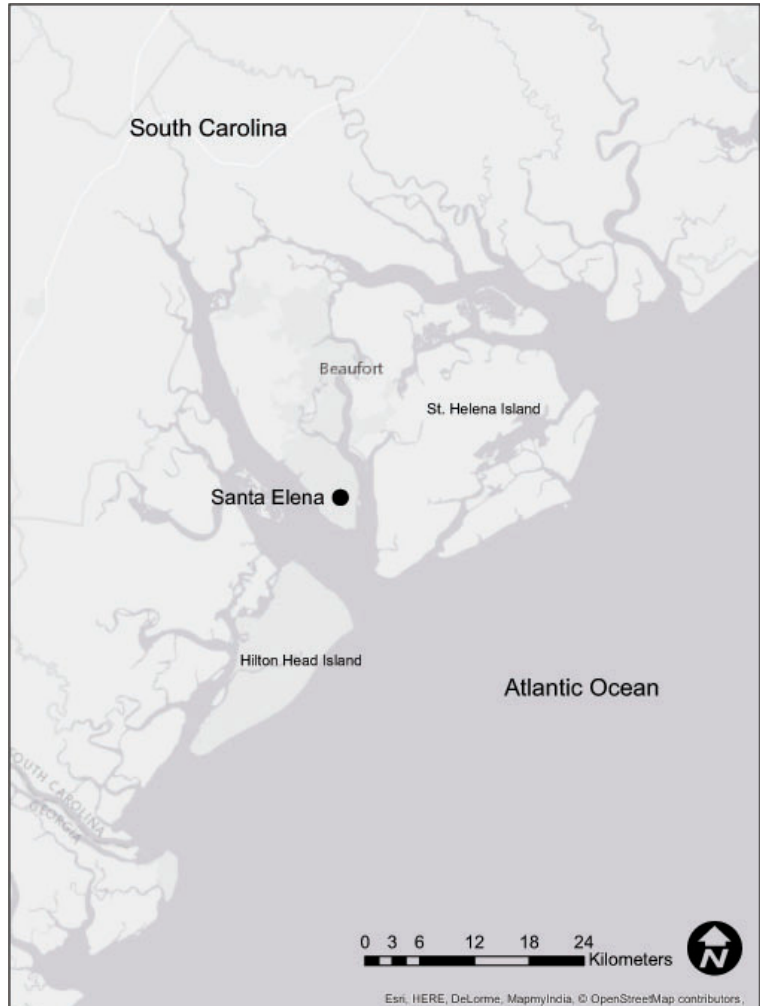
Figure 1. Location of Santa Elena, Parris Island, South Carolina, United States.